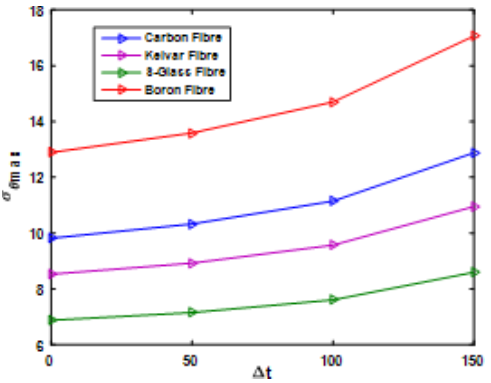
Figure 14: Effect of temperature on σ θ max for different fibre materi- als ( σ ∞ x = σ ∞ x = 1 , [0